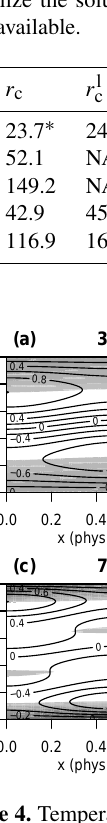
eLEs between r = 130 and r = 160 are close to 2.0, yield-